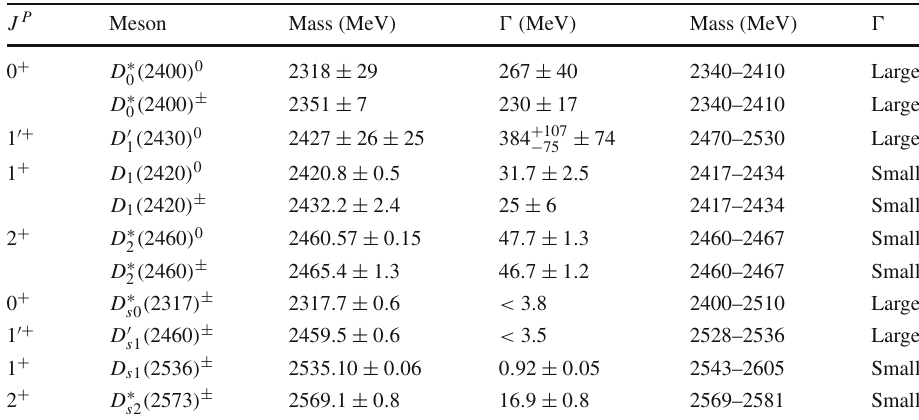
Table 1 Measured masses and J P Meson Mass widths of even-parity charmed mesons. The four p -wave charmed meson states are ∗ , D (cid:3) , D denoted by D ∗ , 1 and D 0 1 2 respectively. In the heavy quark limit, D (cid:3) has j = 1 / 2 and D 1 1 has j = 3 / 2 with j being the total angular momentum of the light degrees of freedom. The data are taken from the Particle Data Group [1]. The last two columns are the predictions from the quark model [7,8].